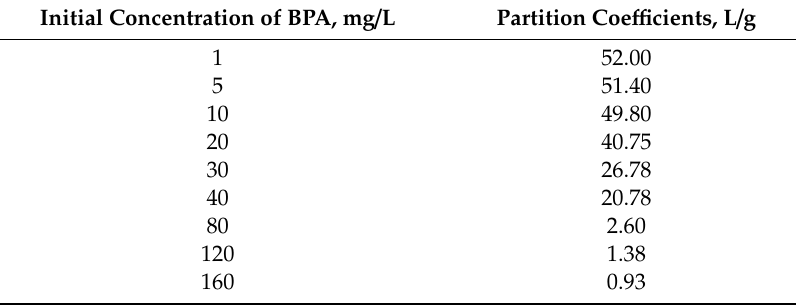
Figure 7. BPA removal (%) in single solutions (red marker) and in binary solutions with ( a ) copper, ( b ) nickel, ( c ) lead and ( d ) cadmium (black marker for metal and blue one for BPA) using activated carbon AC-40 as the adsorbent. Table 6. Partition coe ffi cient in function of